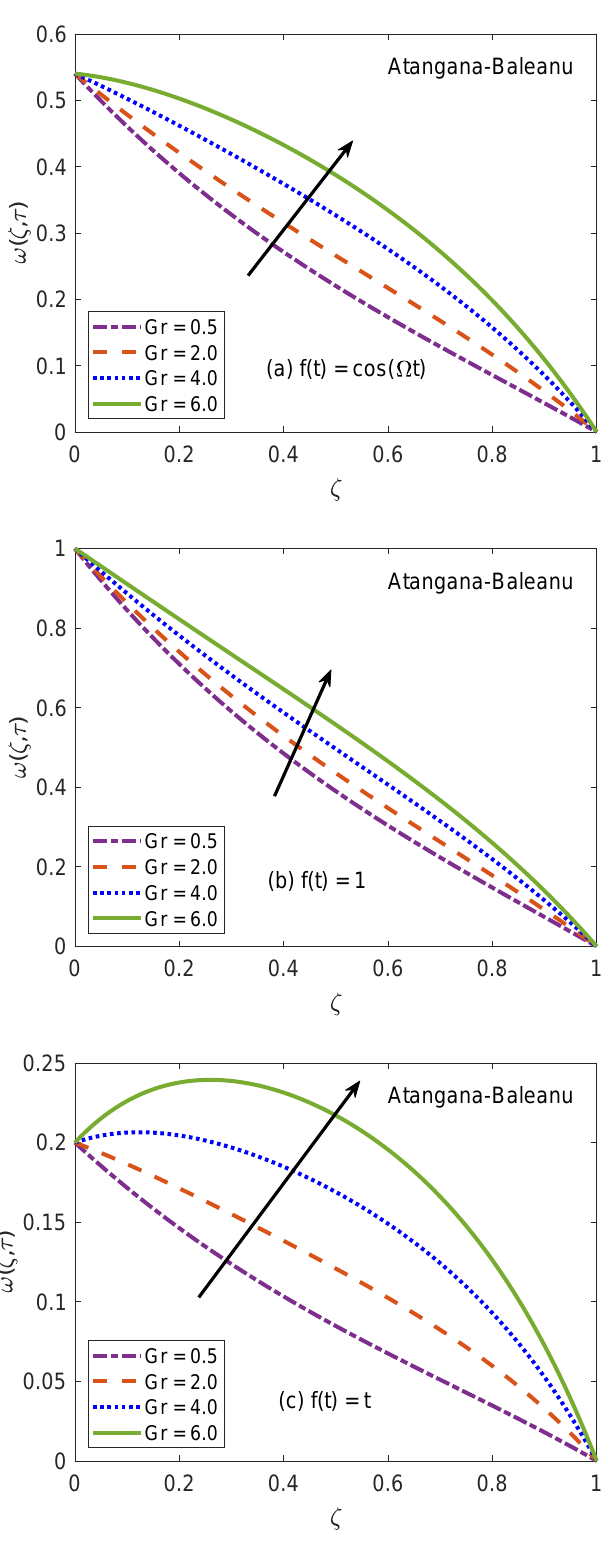
Figure 12. Velocity patterns for variation of Gr